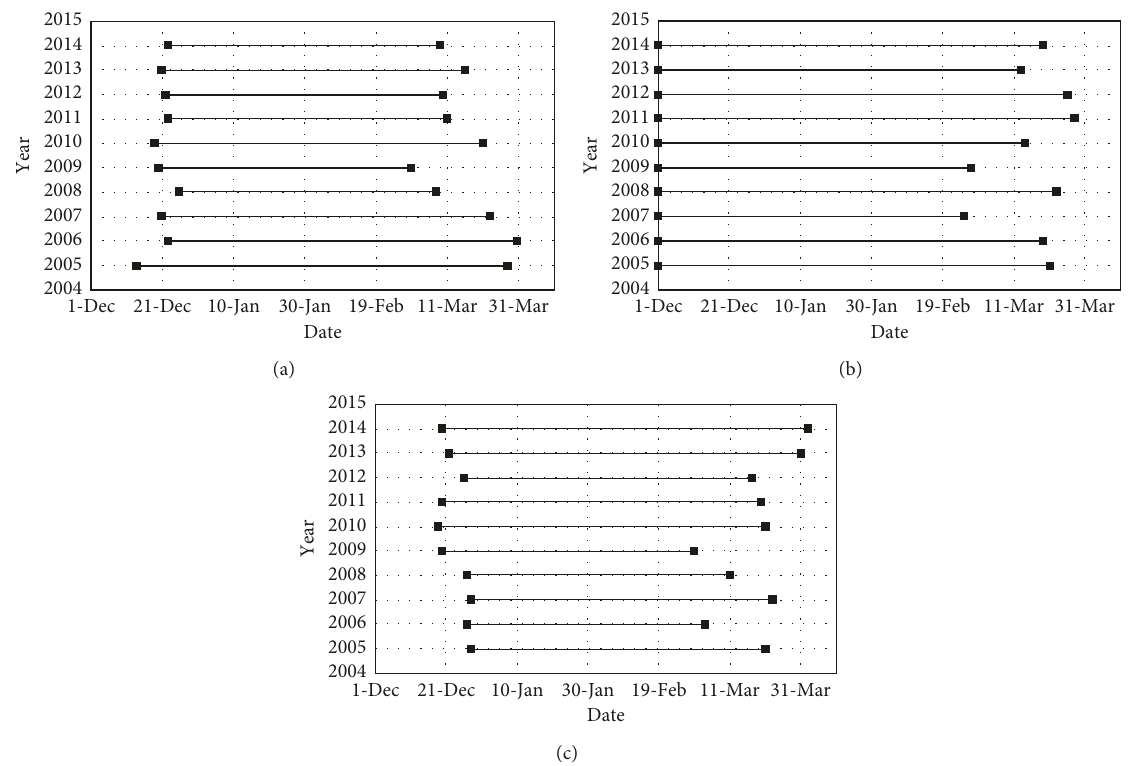
Figure 2: The actual opening records for 2005–2014 seasons for each field. (a) Field A. (b) Field B. (c) Field